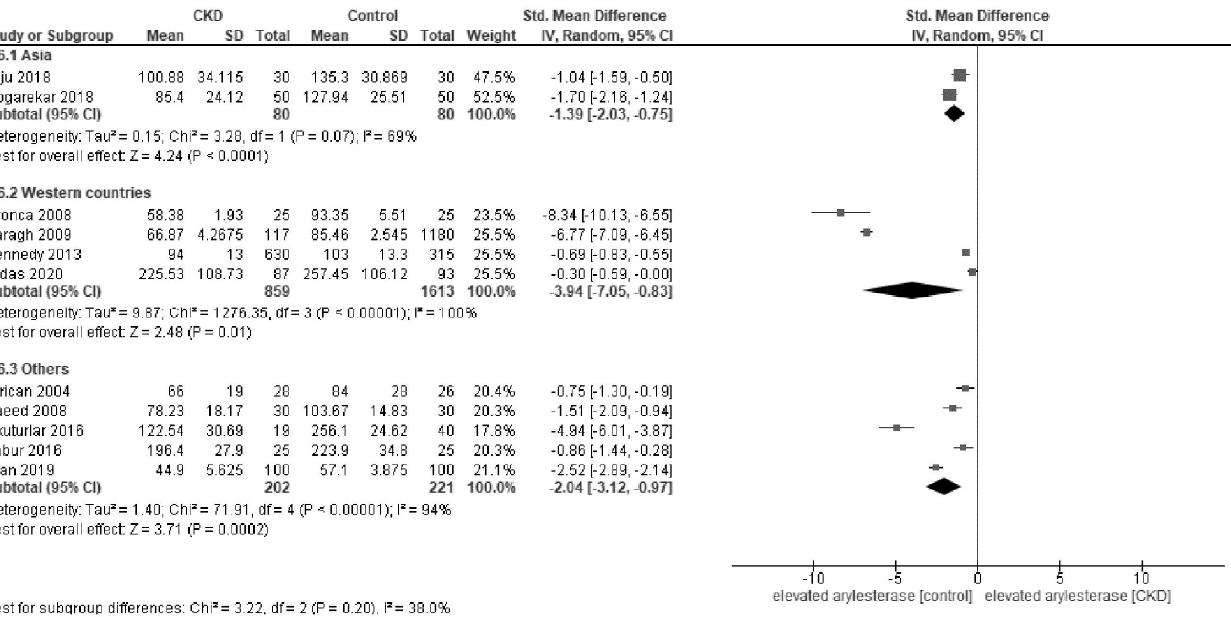
Figure A6. Forest plot of paraoxonase activity in the sensitivity analysis [26–42,44,46–49].